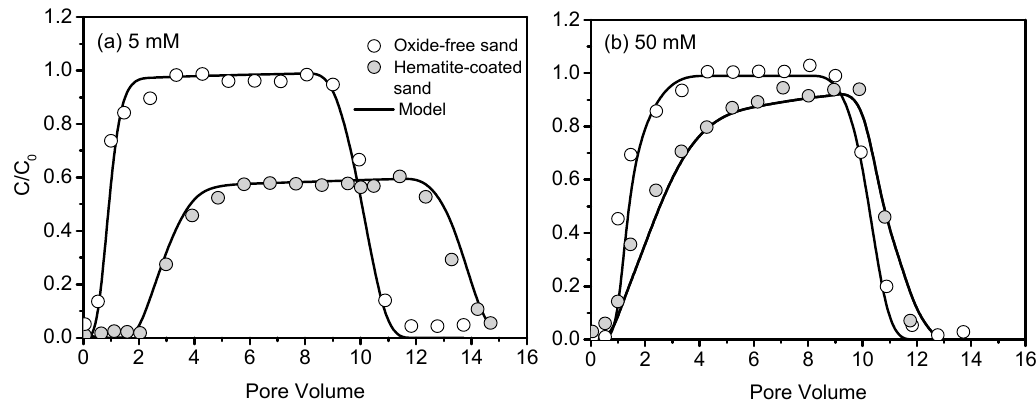
Figure 3. Effect of iron oxide (hematite) on the transport of CNCs through sand at 5 mM ( a ) and 50 mM ( b ).